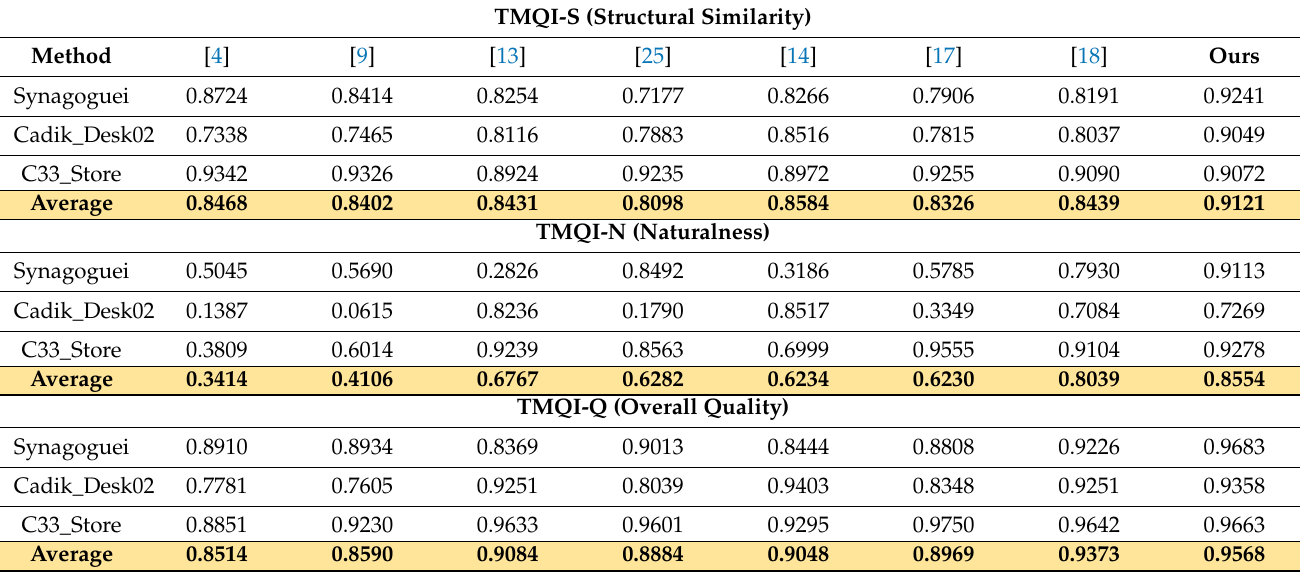
Table 1. Comparison of TMQI-S, TMQI-N, and TMQI-Q using the test images shown in Figures 7–9. TMQI-S (Structural